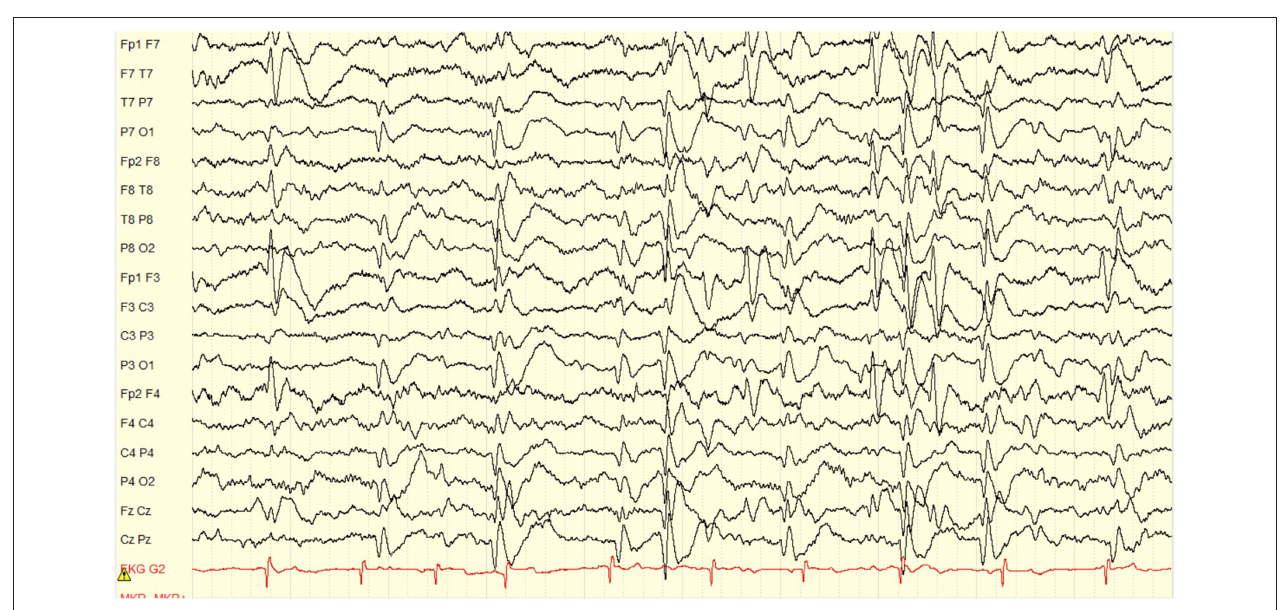
FIGURE 2 | Pre-operative EEG showing an ESES pattern occupying 90% of the sleep recording. The interictal discharges localize to the left frontal, and left occipital regions independently. Volume conduction to the right frontal and right occipital regions is also seen, but the maximum clearly lateralizes to the left hemisphere. Display setup: bipolar double banana montage, 10s page, low frequency filter 1Hz, high frequency filter 70Hz, gain 100 microvolts per cm.